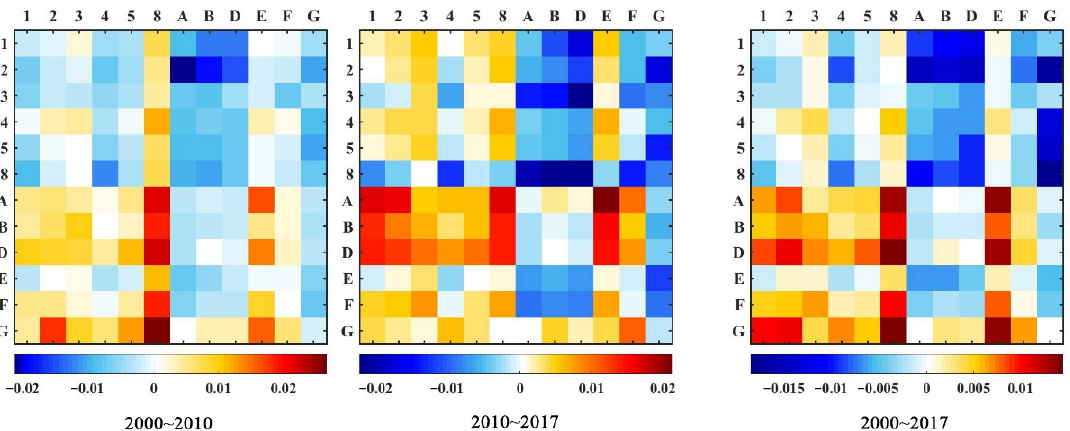
Figure 11. Median slope of LST R series for each LCZ conversion type (the vertical coordinate represents the type of transition out, and the horizontal coordinate represents the type of transition in).